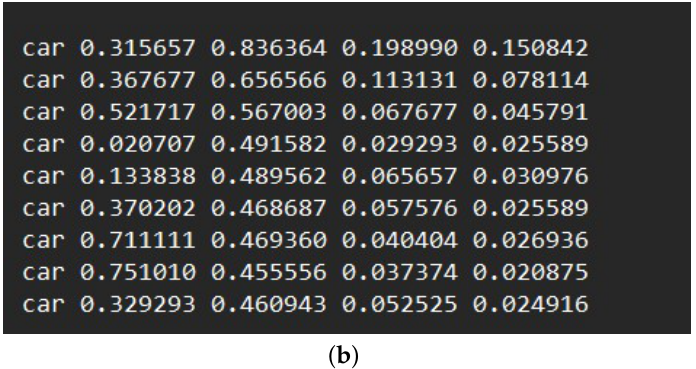
Figure 5. An example image annotated in LabelImg software. ( a ) Shows sample image with bounding boxes on vehicle instances; ( b ) Shows text file with { classlabel , x , y , w , h } for each vehicle